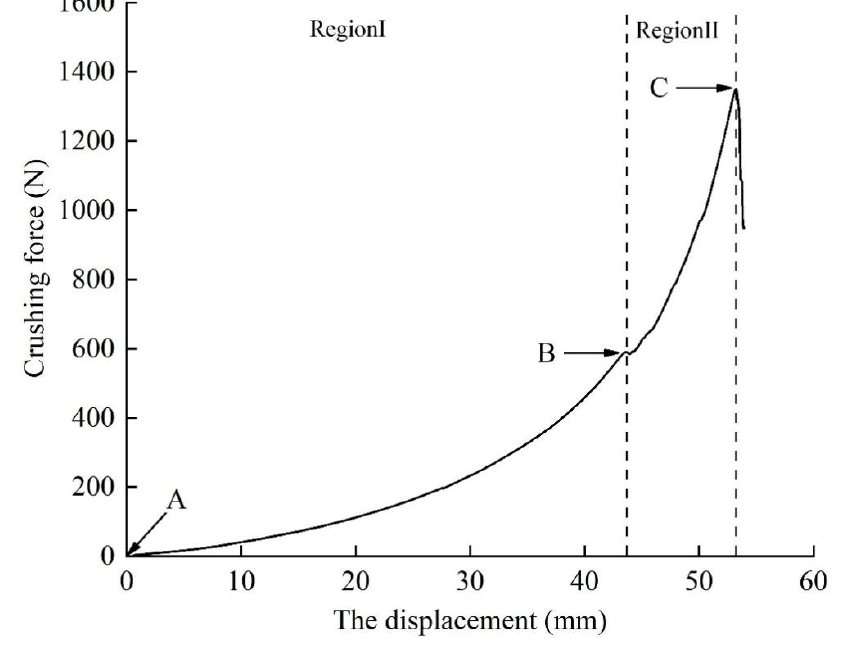
Figure 3. Curve of crushing force and displacement.